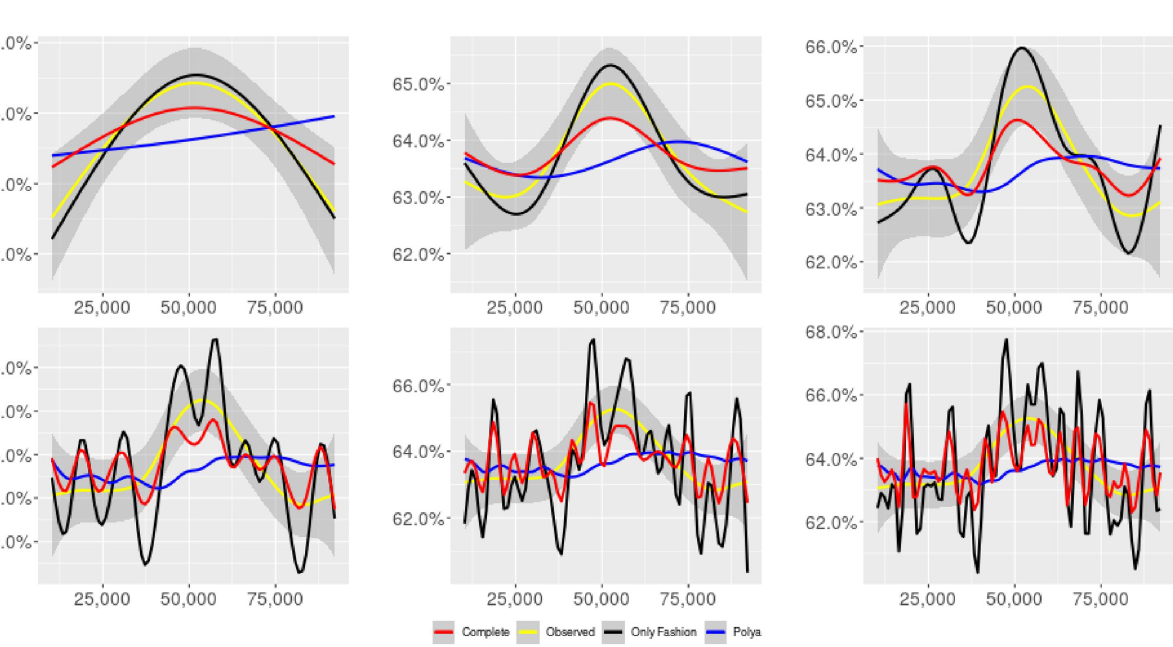
Fig 4. “10 days of traffic” ( T = 0.35, only BOTs’ posts, D = 30 00 , S = 100 slots of equal size): Sentiment curves for BOTs’ postsx. In each panel, the yellow line is the cubic spline smoothing of the time series of the observed tweets ξ n +1 , together with the default confidence interval (gray), the red line represents the cubic spline smoothing of the time series of the estimated predictive means ^ c (defined in Subsec. 3.2), obtained with the complete RP n model, the black and the blue lines provide similar approximations obtained with the other models: black = Only fashion RP model and blue = Standard Po´lya model. In each panel, the smoothing is obtained with a given number of nodes: k = 3 (top left panel), 5 (top middle panel), 10 (top right panel), 20 (bottom left panel), 30 (bottom middle panel), 50 (bottom right panel).